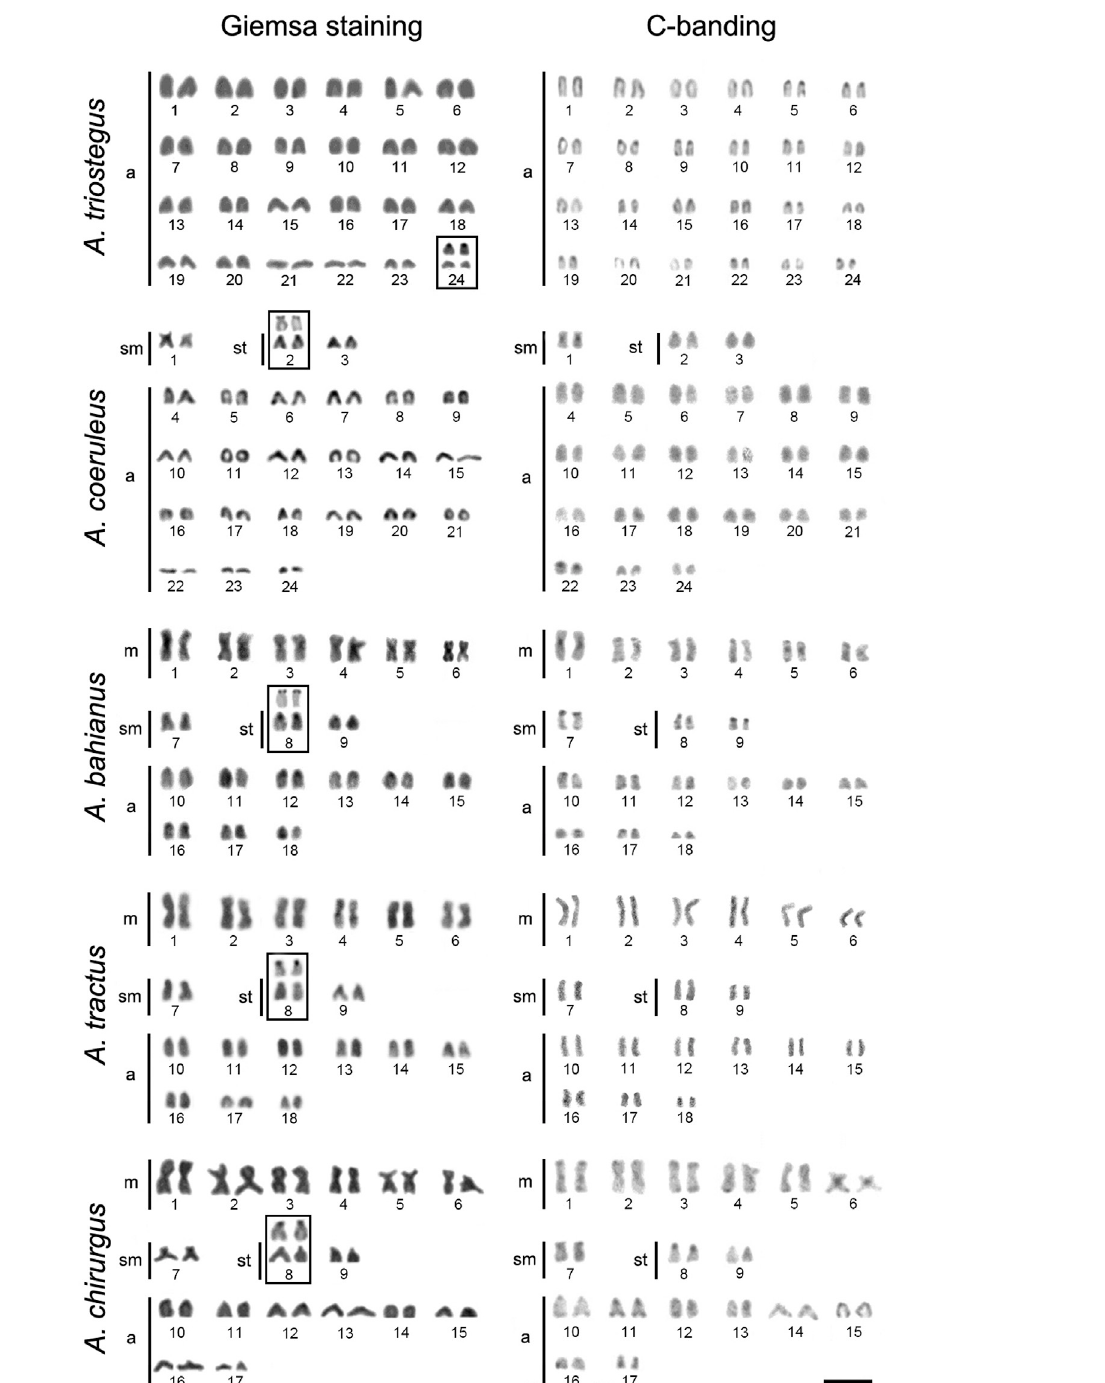
Frontiers in Genetics |